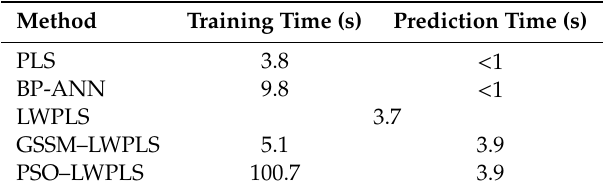
Table 4. Comparison of the computation times of the five methods.